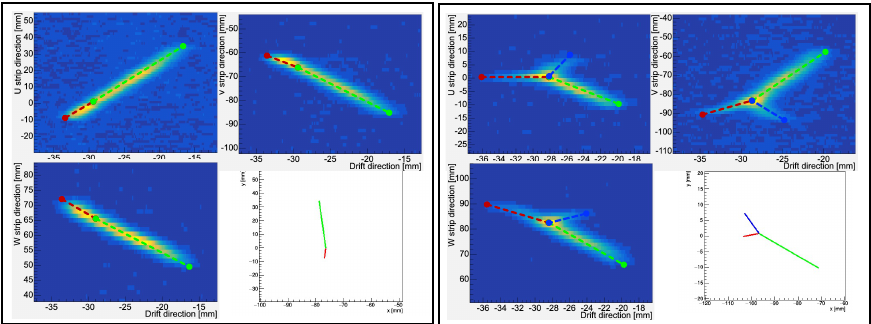
Figure 1. Event reconstruction example for an 16 O (left) and a 12 C (right) photo-disintegration event at E γ = 8.66 MeV. The raw data for the charge collected by each strip (U, V, W) strip is plotted as a function of strip position and time (both rescaled to mm), while the bottom-right plot shows the projection of the reconstructed tracks on the anode